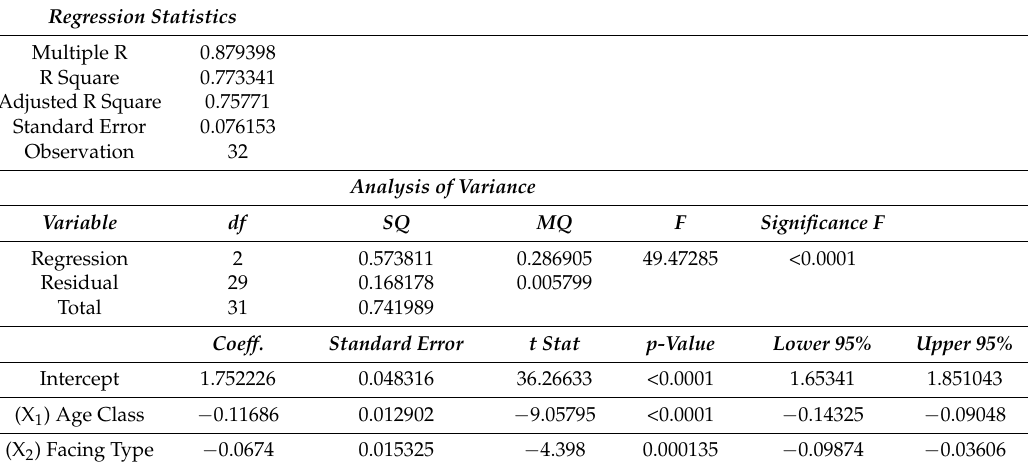
Table 2. Global model: regression statistics and ANOVA.